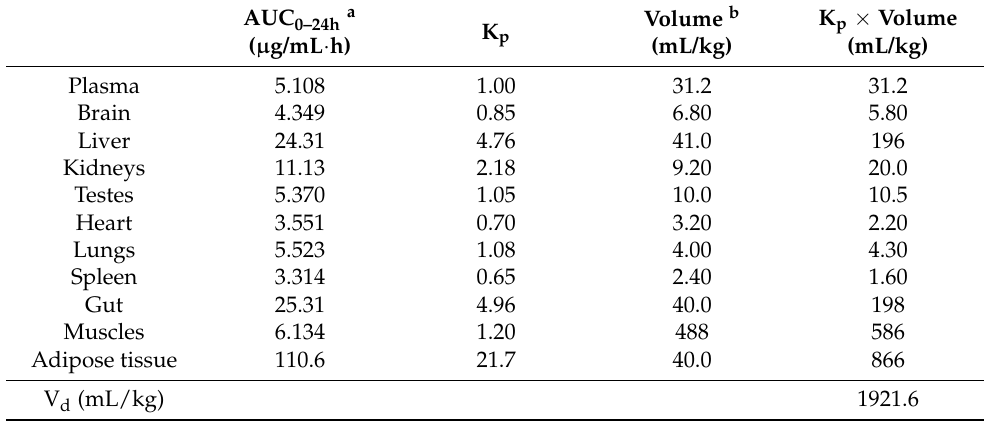
Table 4. Distribution of supinoxin after oral administration (5 mg/kg) and tissue volume of